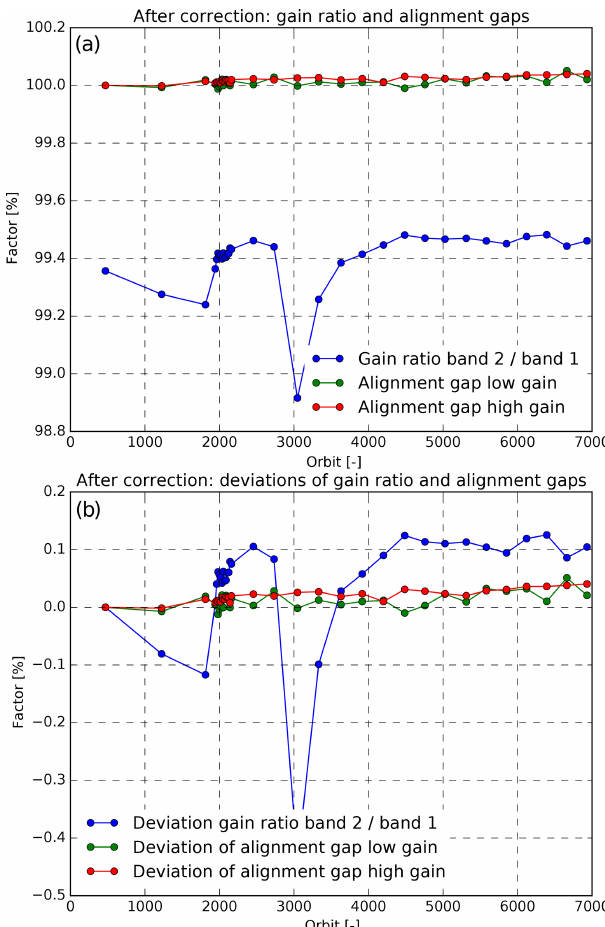
Figure 4. With CCD gain drift correction, the alignment correction factor ratio between bands 1 and 2 for low-CDD-gain (green) and high-CDD-gain (red) setting together with the relative drift of the originally computed gain ratios (blue). Panel (a) shows the absolute values, and panel (b) shows the values relative to the first available in-flight data. The alignment correction factor ratio is around 1 after the gain drift